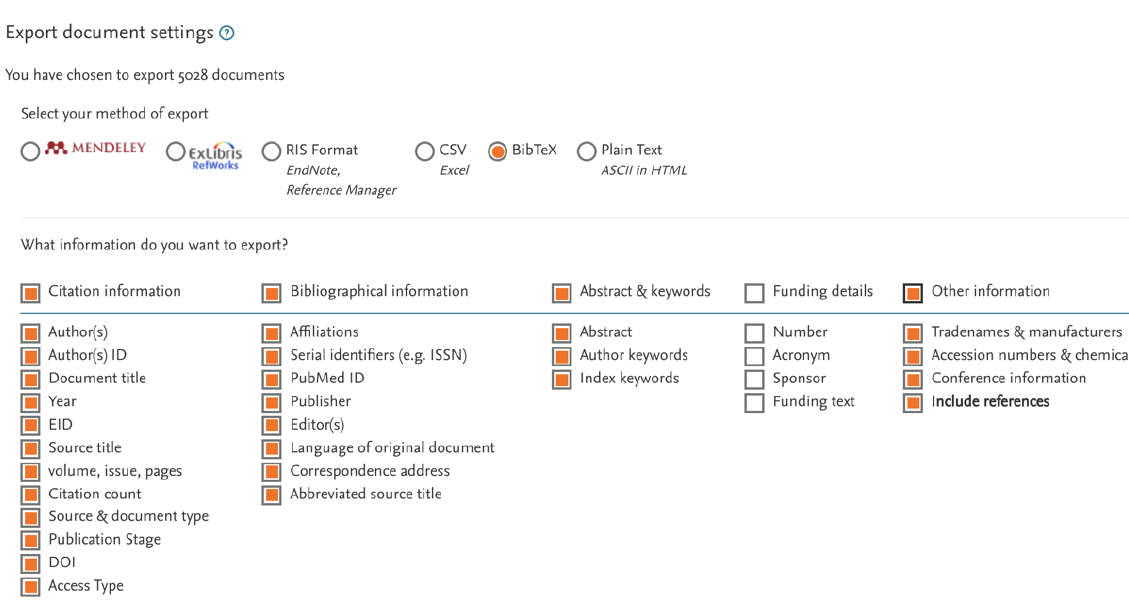
Fig. 2. SCOPUS Export